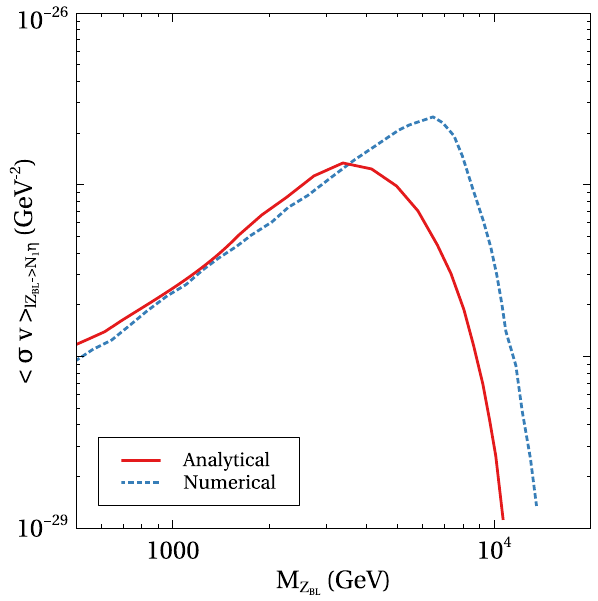
Fig. 9 Comparison of analytical and numerical results for the thermal averaged cross section of the key washout process lZ BL −→ N 1 η at temperature T = 100 M 1 . The relevant benchmark parameters are fixed at the following values m η = 500 GeV, M 1 = 10 TeV, g BL = 0 . 1, ( Y η ) α (cid:14) 10 − 1